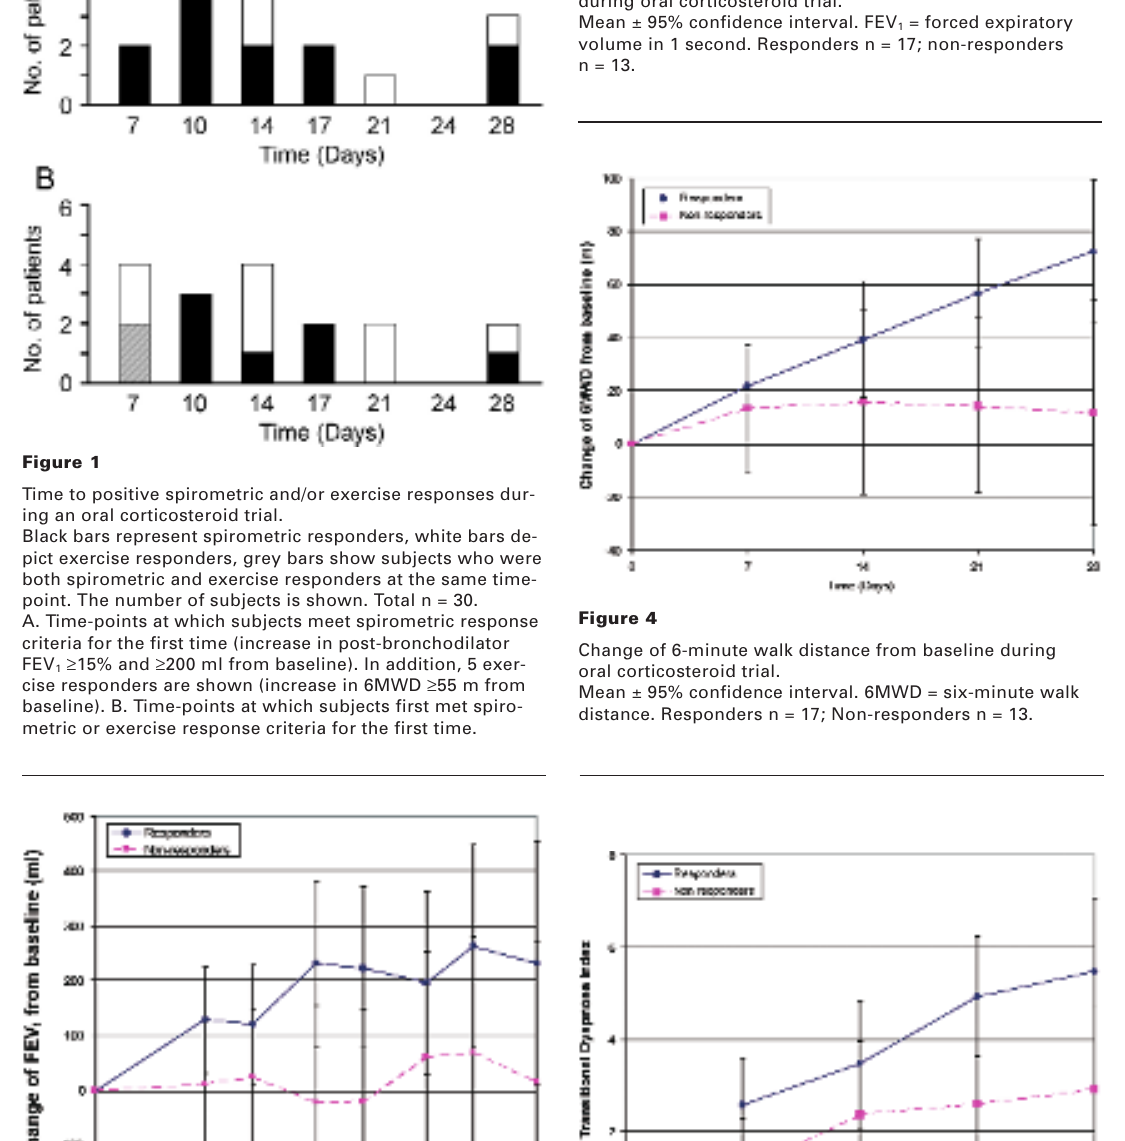
Figure 2 Change of postbronchodilator FEV 1 from baseline in ml during oral corticosteroid trial. Mean ± 95% confidence interval. FEV 1 = forced expiratory volume in 1 second. Responders n = 17; non-responders n = 13.